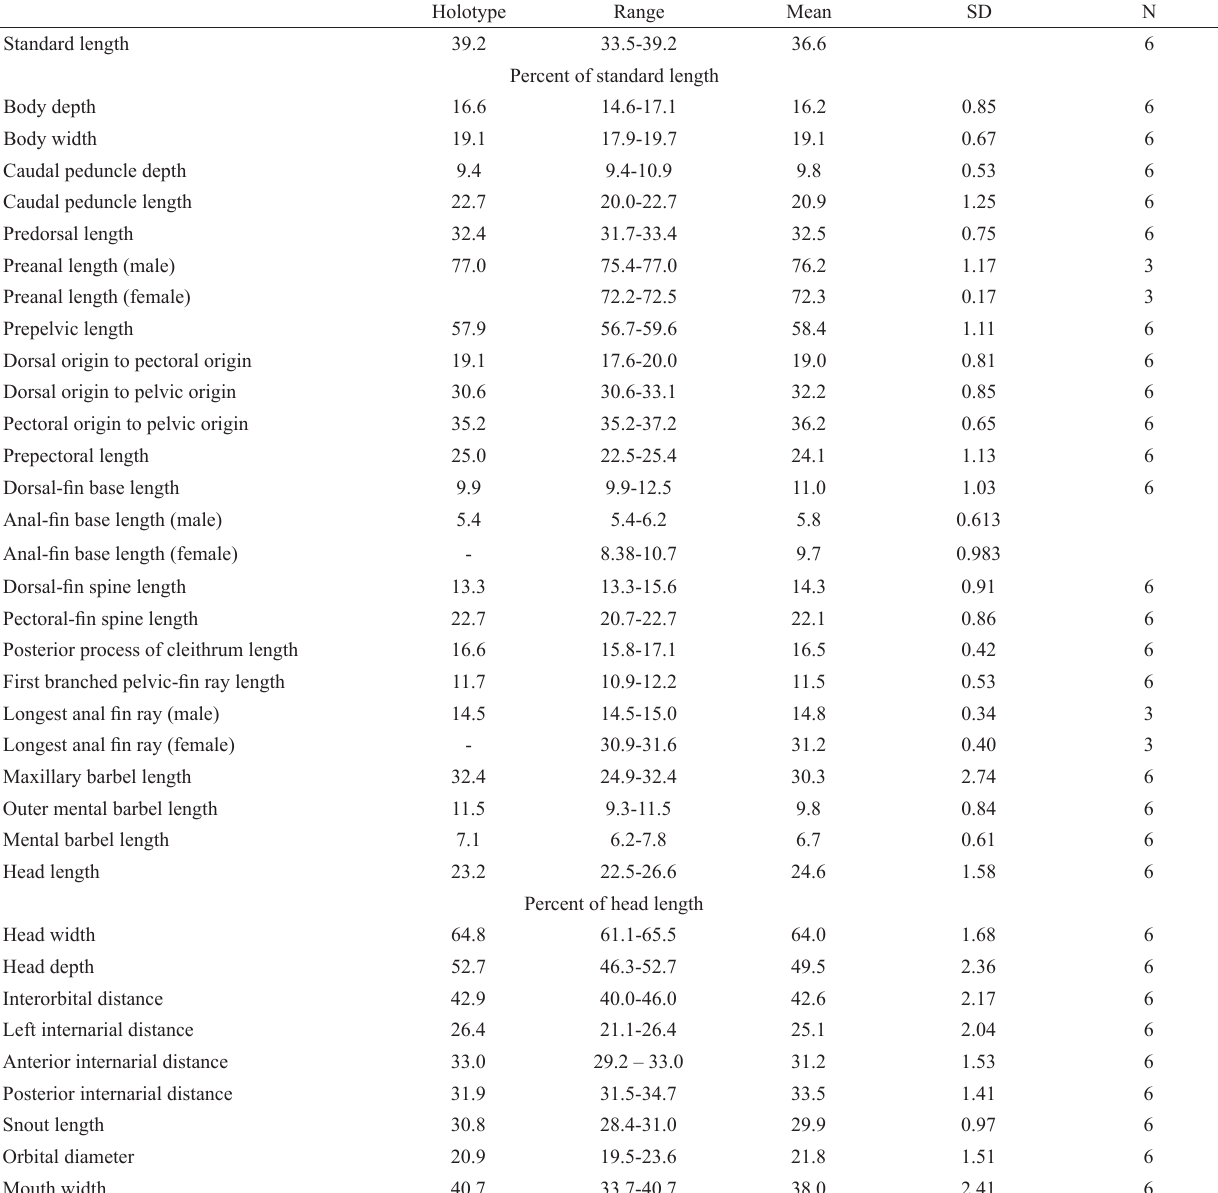
Table 1. Morphometric data for Centromochlus britskii . SD = Standard deviation; N = holotype plus 5